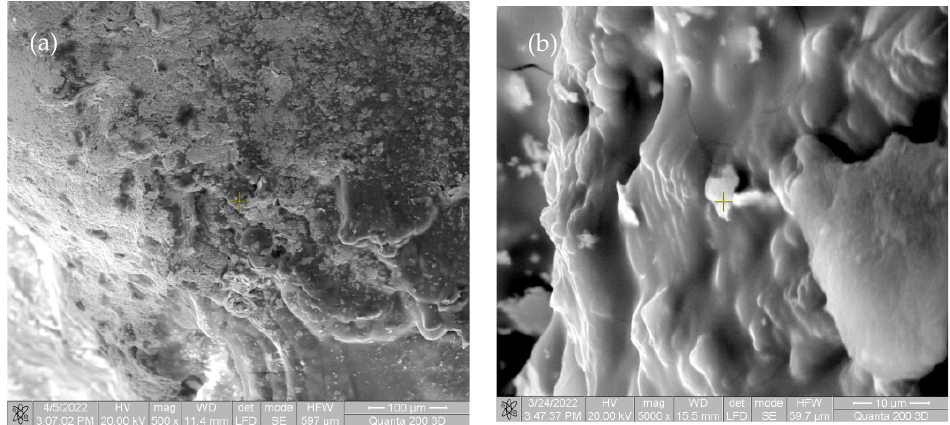
Figure 7. SEM images of rats after four weeks for Mg-0.5Ca-1.5Y ( a ) at magnification of 500 × ; ( b ) at magnification of 5000 ×